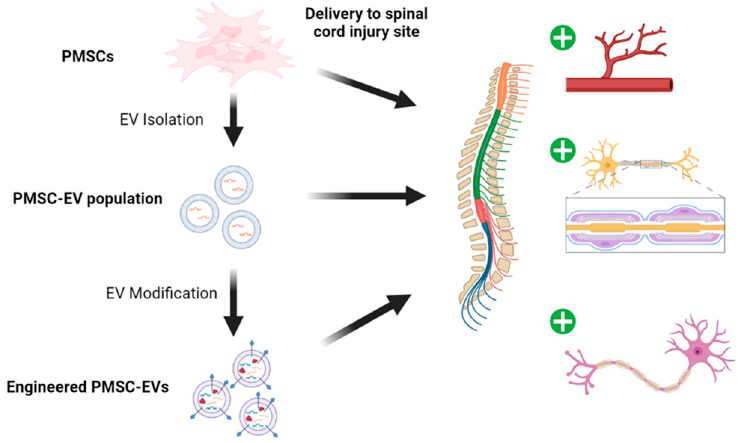
Figure 1. PMSCs, PMSC-EVs and engineered PMSC-EVs can each confer therapeutic effects in SCI by stimulating angiogenesis, remyelination, neuroprotection, and reducing inflammation. by stimulating angiogenesis, remyelination, neuroprotection, and reducing